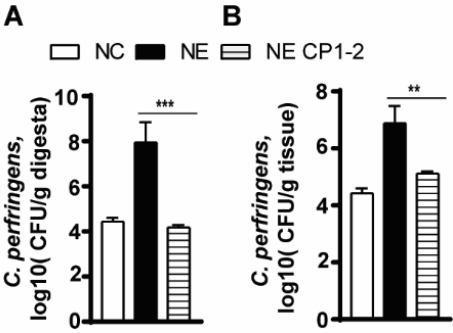
Figure 5. CP1-2 vaccine reduced C. perfringens colonization and invasion in the small intestine of NE birds. Bird experiment was conducted as in Figure 4. ( A ) Luminal C. perfringens colonization level in the intestinal content. ( B ) C. perfringens invasion level in the intestinal tissue. All graphs depict mean ± SEM. ***, p < 0.001; **, p < 0.01. Results are representative of two independent experiments.